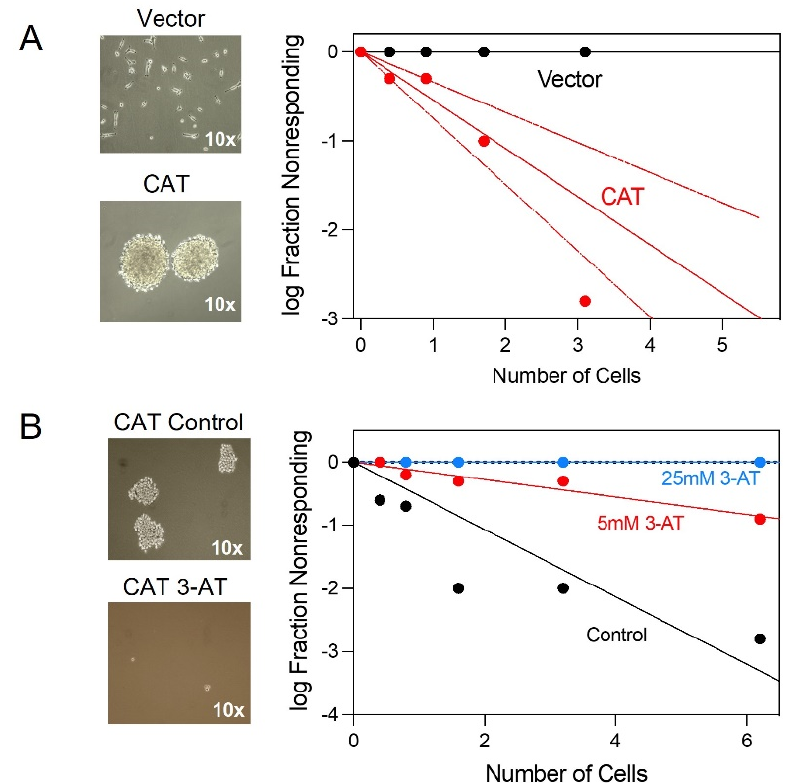
Figure 5. Effect of CAT overexpression on neurosphere formation. In vitro limiting dilution assays of ( A ) vector and CAT expressing cells; ( B ) CAT expressing cells in the presence or absence of 3 − AT. Results represent the average from two independent experiments.